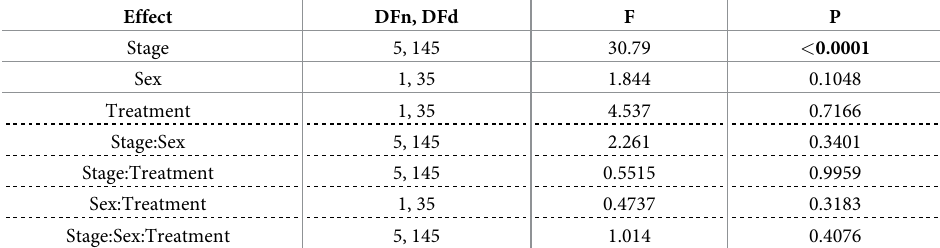
Summary of results from a linear mixed effects model testing the effects of naupliar warming exposure on mass- specific respiration rates. Warming treatment, sex, and copepodite stage and their interactions were included in the model as fixed effects, while experiment replicate and individual copepod were included in the model as random effects.